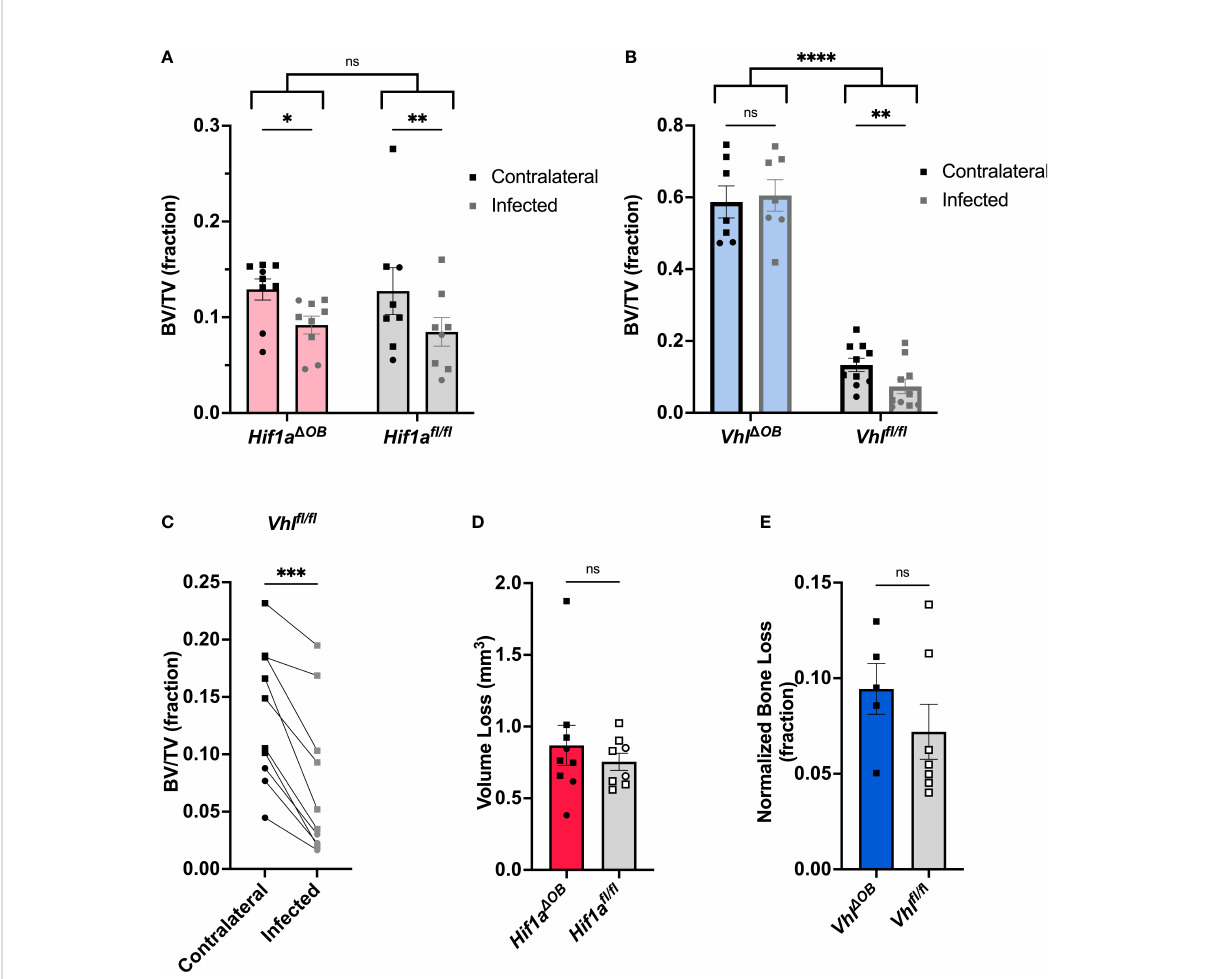
FIGURE 2 Vhl D OB mice do not lose trabecular bone volume during osteomyelitis. (A) Trabecular bone volume per total volume (BV/TV) in Hif1a D OB mice and Hif1a fl / fl littermate control mice ( n =8-9) was measured in the distal metaphysis of infected and contralateral femurs using microCT. (B) BV/ TV was measured in the infected and contralateral distal metaphyses of femurs in Vhl D OB mice and Vhl fl / fl littermate control mice ( n =7-10). Squares represent males, and circles represent females; * p < 0.05, ** p <0.01, and ns denotes not signi fi cant ( p >0.05) as determined by two ‐ way analysis of variance (ANOVA) (A, B) . Comparison of bracketed genotypes refers to two-way ANOVA comparison of genotypes as a whole without multiple comparisons by laterality of femur, denoted with **** p <0.0001. (C) The data from Vhl fl / fl littermate control mice ( n =10) analyzed in (B) are shown in an enlarged graph with lines denoting paired contralateral and infected femurs. *** p <0.001, as determined by paired, two-tailed Student ’ s t -test. (D) Volume of cortical bone loss in the infected femur in Hif1a D OB or Hif1a fl / fl littermate control mice ( n =8) was determined using microCT at post-infection day 14. Squares represent males, and circles represent females. (E) Cortical bone loss at post- infection day 14 in the infected femurs of n =5-7 male Vhl D OB or Vhl fl / fl littermate control mice was determined using microCT and is expressed as a normalized ratio relative to equivalent analysis performed on the contralateral femur. ns denotes not signi fi cant ( p >0.05) as determined by unpaired, two-tailed Student ’ s t -test (D, E) . Error bars represent